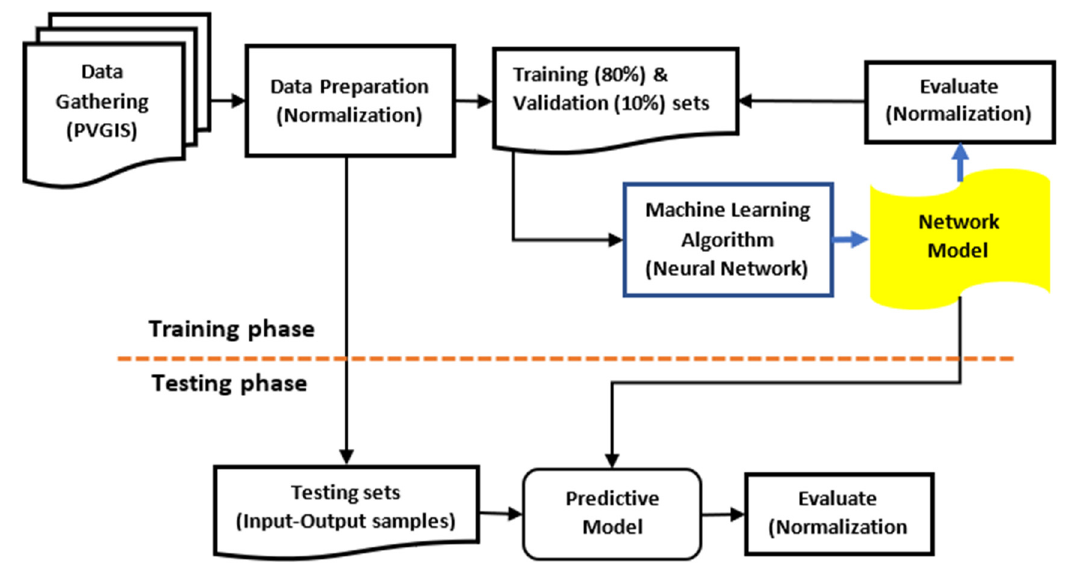
Figure 2. Methodology used to develop the feed-forward neural networks (FFNN) model.